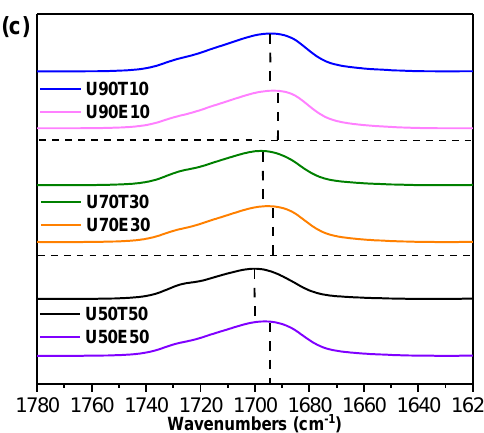
Figure 5. ( a ) The C = O stretching regions of the U and UT blends, ( b ) the N-H stretching regions of the U and UT blends, and ( c ) the C = O stretching regions of the UT blends and UE blends in the FT-IR spectra. Each spectrum in ( b ) was resolved into its components by the curve-fitting method.